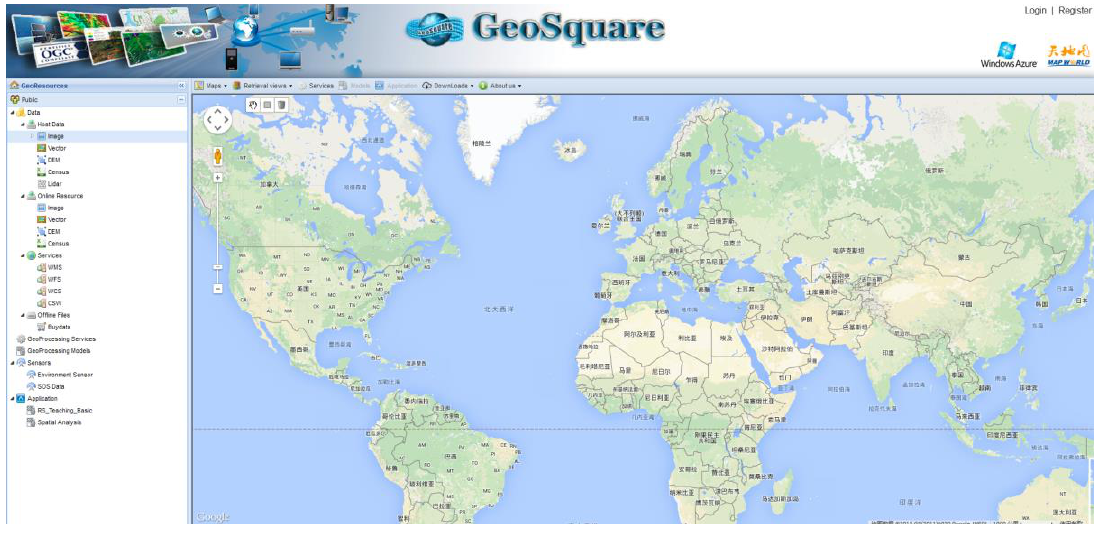
Figure 2 Interface of